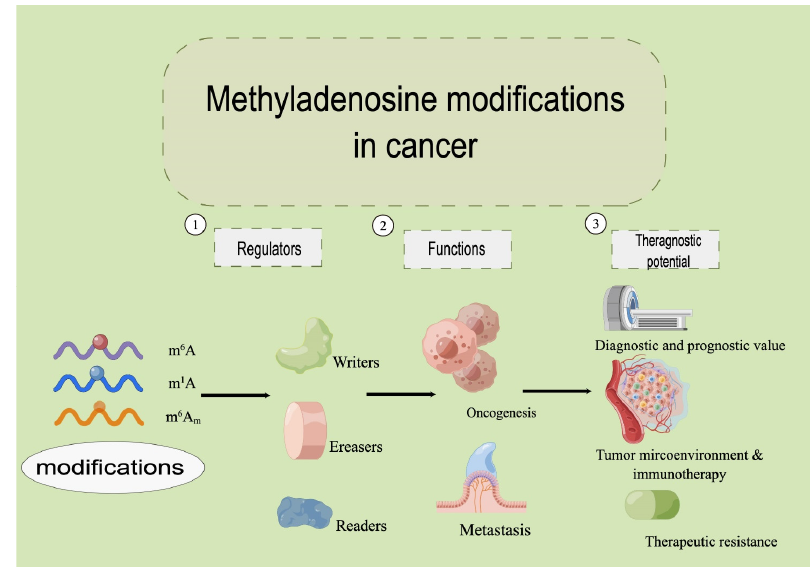
Figure 1. The overview of the methyladenosine modifications in cancer.